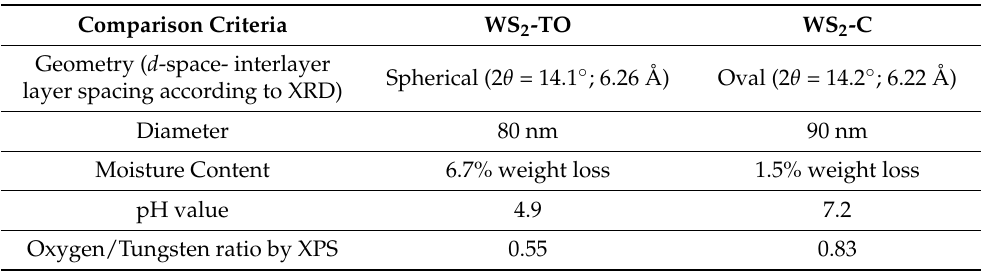
Table 1. Intrinsic properties of the WS 2